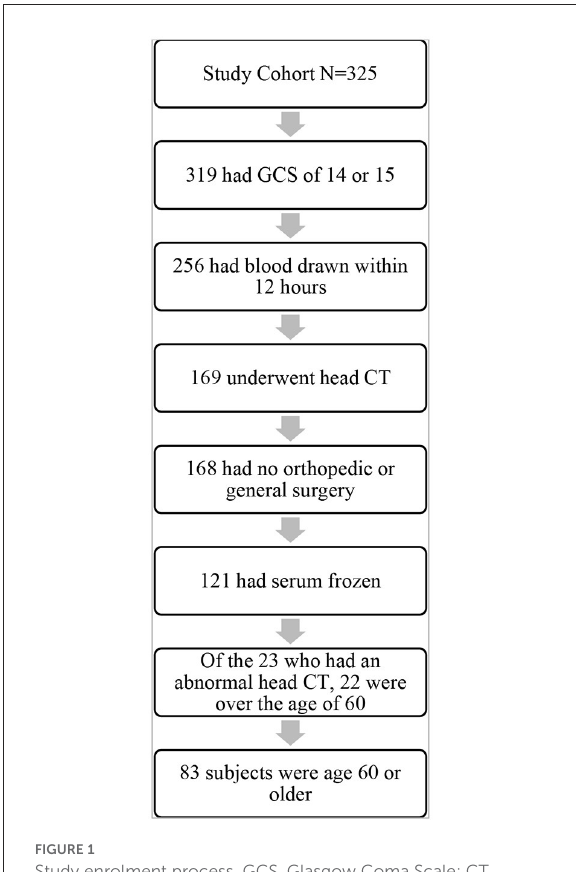
FIGURE1 Study enrolment process. GCS, Glasgow Coma Scale; CT, computed tomography.